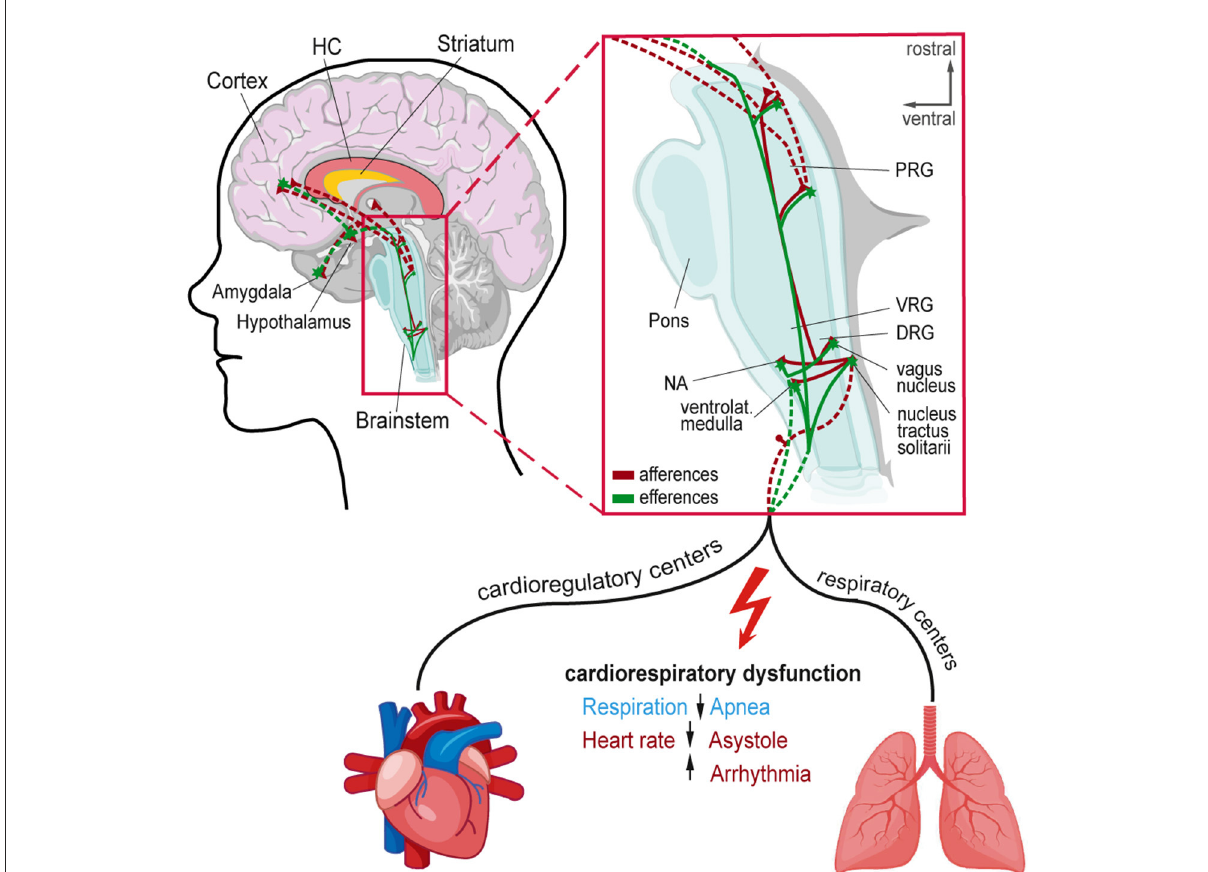
FIGURE1 Afferent and efferent connections to central autonomic networks and proposed mechanisms involved in seizure-induced cardiorespiratory dysfunction leading to SUDEP. Cortical and subcortical regions involved in epileptic activity and cardiorespiratory modulation in the brainstem. Magnification shows connections and brainstem nuclei of cardioregulatory and respiratory centers that can be affected by seizure activity leading to cardiorespiratory dysfunction. DRG, Dorsal respiratory group; HC, Hippocampus; NA, Nucleus ambiguous; PRG, Pontine respiratory group; VRG, Ventral respiratory